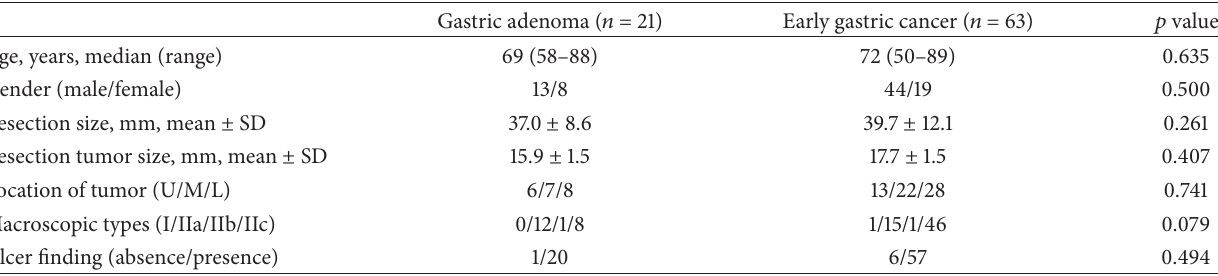
Table 1: Clinical characteristics of patients.